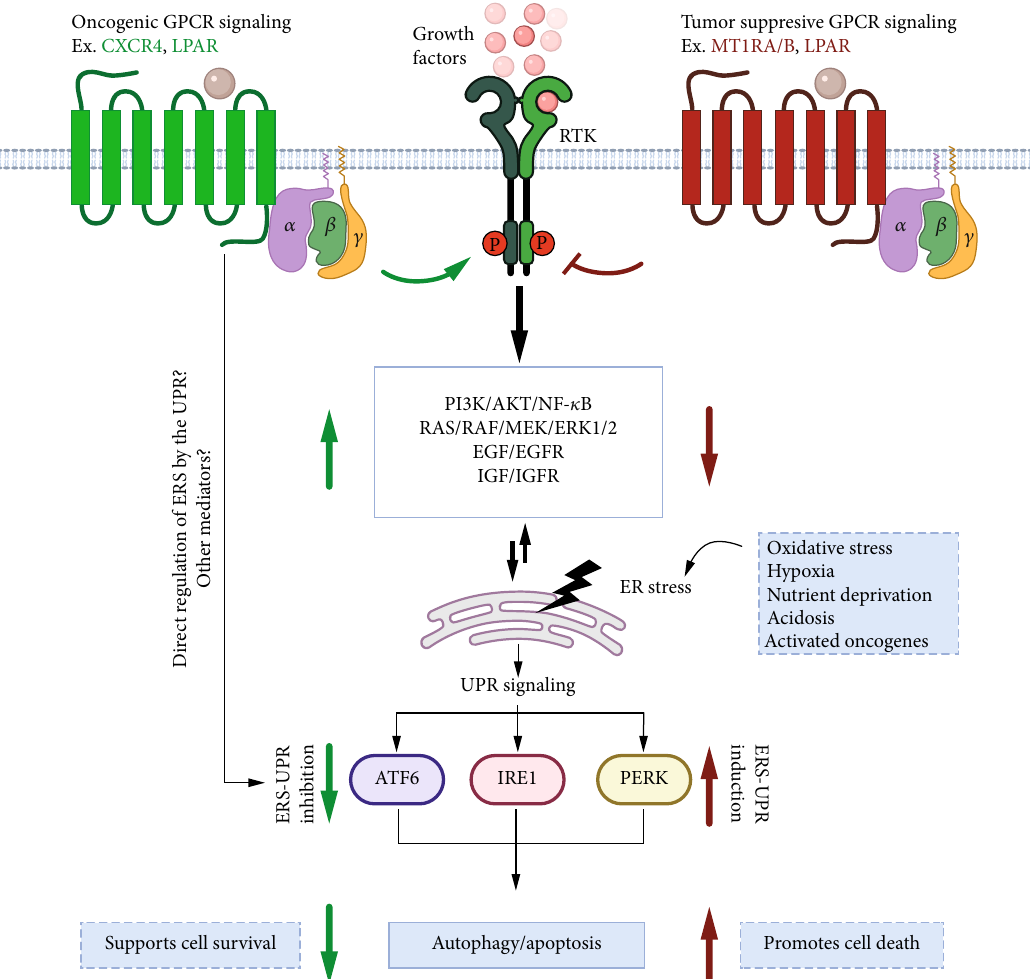
Figure 3: GPCR-ERS-UPR in cancer. Overexpression of the GPCRs with oncogenic roles (e.g., CXCR4 and LPAR, green) in the conditions of hypoxia, nutrient deprivation, ROS, activated oncogenes, or acidic environment is associated with activation of survival pathways (PI3K/AKT/NF- κ B, MAPK, and growth factor mediated signaling) to support cancer cell survival. At the same time, via regulation of IRE, ATF6, and PERK, GPCRs can inhibit cell death pathways, apoptosis, and cytotoxic autophagy (signaling indicated with green arrows). On the other hand, GPCRs with anticancer roles (MT1RA/B and CNR1/2, red) are associated with activation of the ERS-mediated UPR signaling to induce apoptosis and autophagy-related cell killing (signaling indicated with red arrows). Complex bidirectional crosstalk between UPR pathways and various cell survival and growth signaling pathways is involved in mediating the GPCR-related cancer cell fate. However, the exact sequence of this crosstalk for a given GPCR or other possible mediators still needs to be